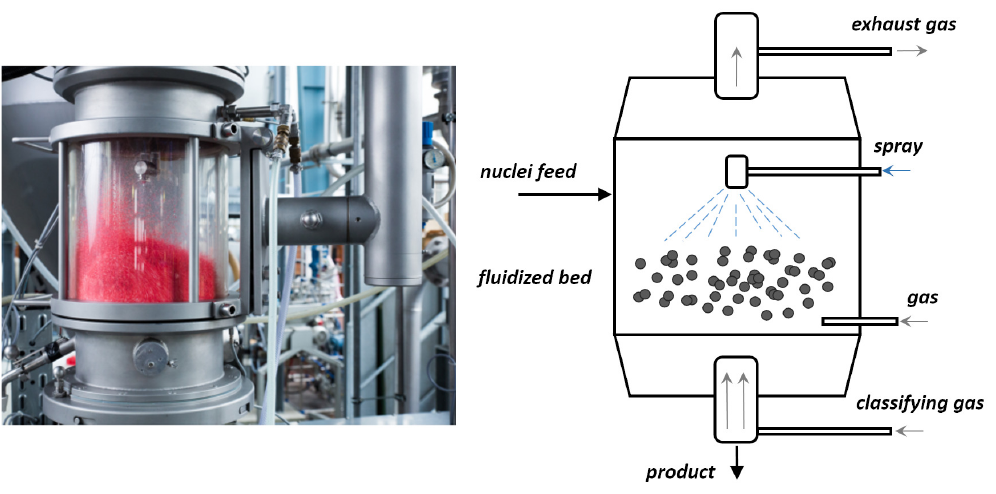
Figure 1. ( Left ) Real pilot scale fluidized bed used for experiments ( Right ) Schematic representation of fluidized bed spray agglomeration process.